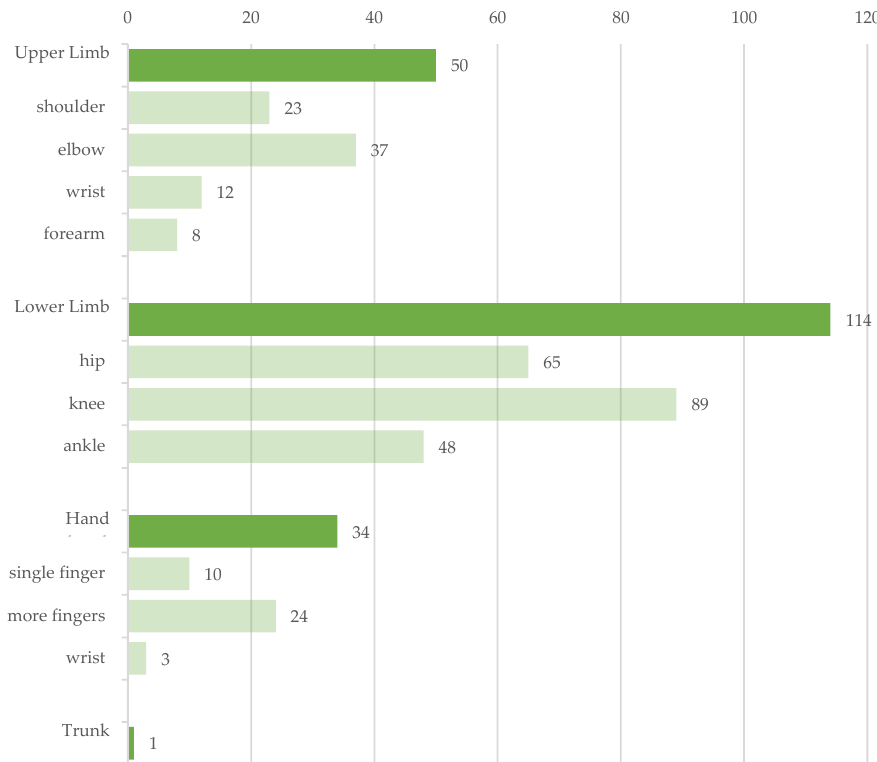
Figure 10. The distribution of exoskeletons by anatomical districts. The 57% of revised articles deals with lower limb exoskeletons and knee devices are dominant. For the upper limbs, the elbow is the most considered joint and multiple fingers for the hand.